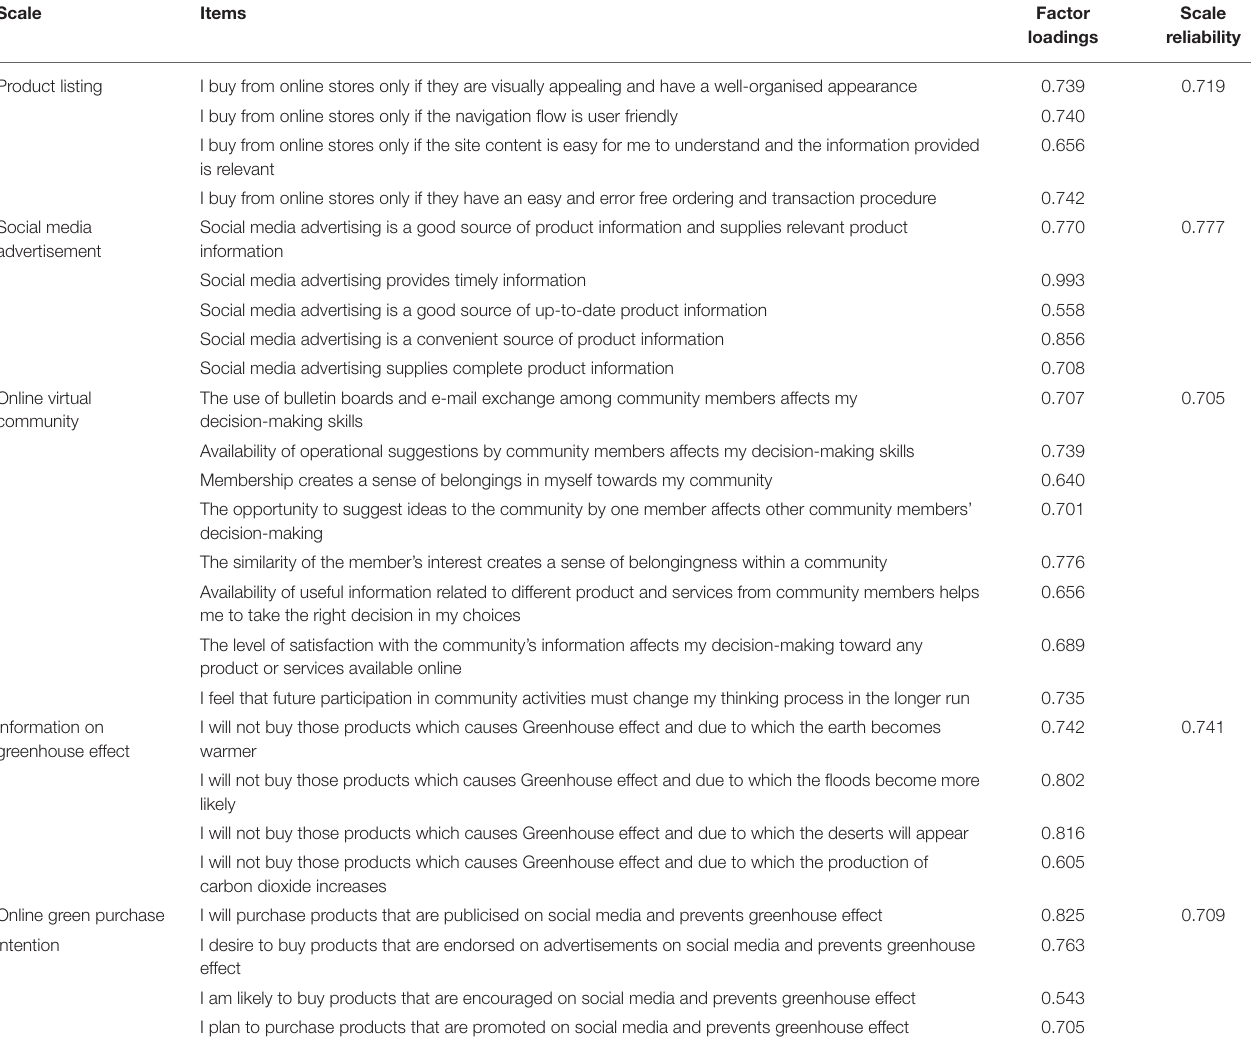
TABLE 3 | Pooled confirmatory factor analysis (independent, mediating, and dependent